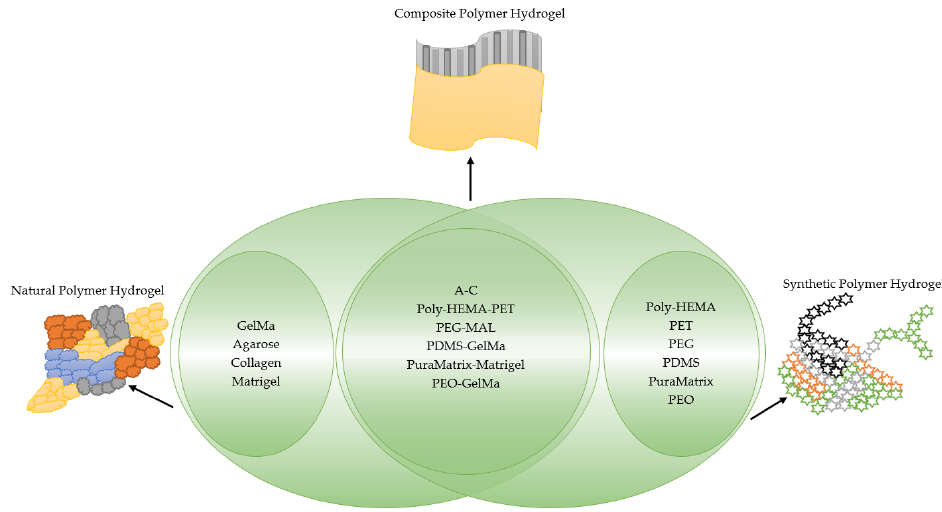
Figure 1. General polymer hydrogels developed for cancer cell